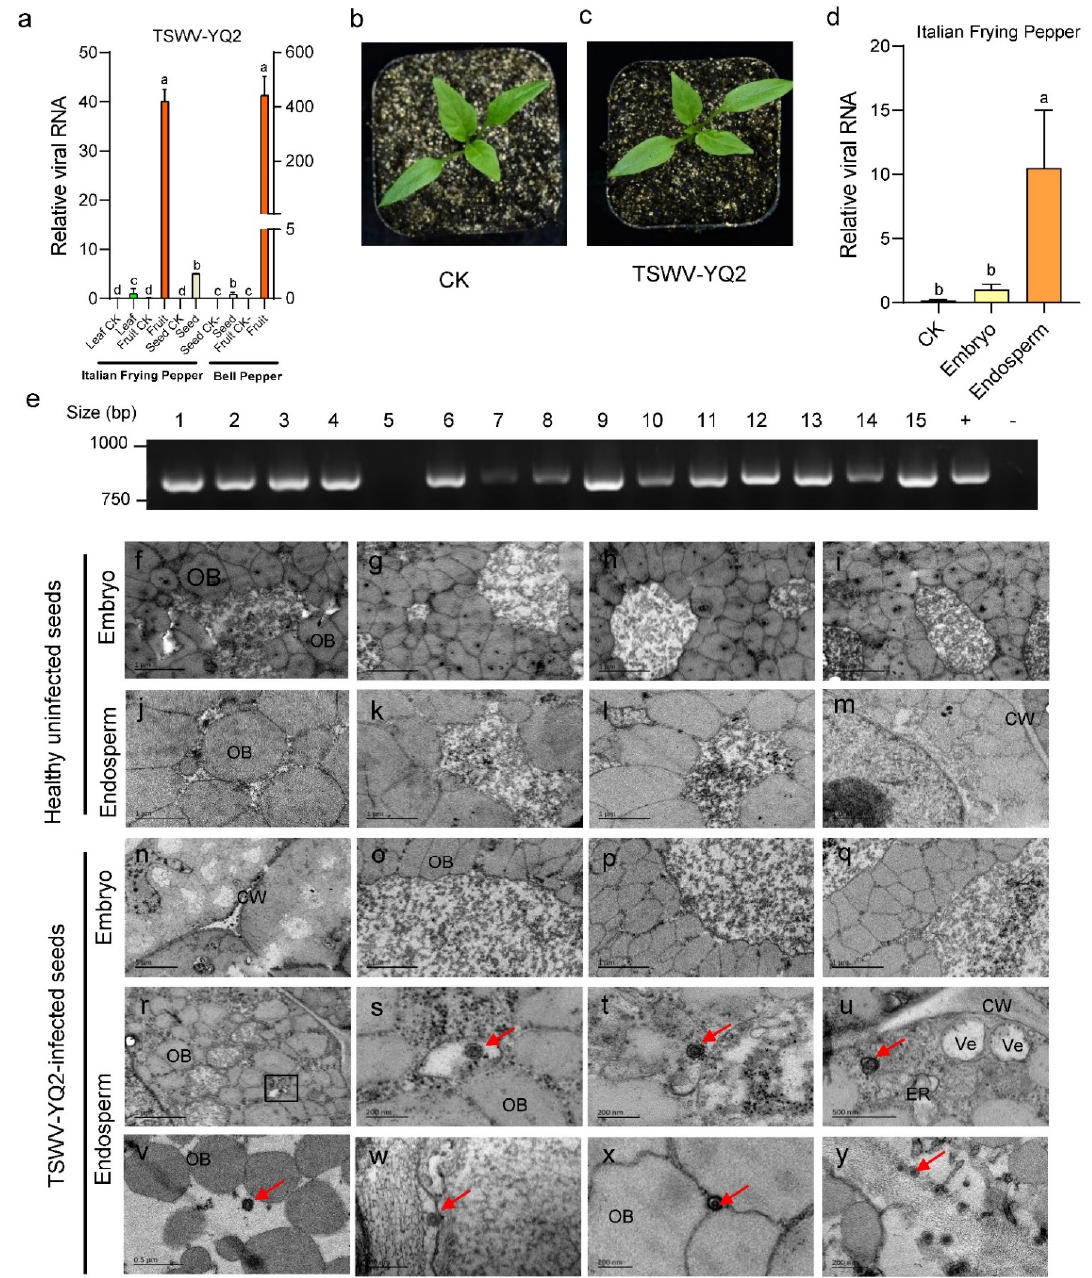
Figure 2. Characterization of seed transmission of TSWV in peppers. ( a ) Relative viral RNA level of the nucleocapsid ( N ) gene in the leaves, fruits, and seeds of TSWV-YQ2-infected Italian frying peppers and in the fruits and seeds of TSWV-YQ2-infected bell peppers. Leaf CK/fruit CK/seed CK, leaf/fruit/seed negative control (healthy uninfected Italian frying pepper leaves/fruits/seeds). Seed CK/fruit CK, seed/fruit negative control (healthy uninfected bell pepper seeds/leaves). Values are means ± SE, n = 4. Means with different letters (a, b, c, d) are significantly different ( p < 0.05, one-way ANOVA along with Duncan’s multiple range test). Each value was normalized to the leaves. ( b , c ) Seedlings germinated from healthy seed (CK) and seed collected from TSWV-YQ2-infected Italian frying peppers (TSWV-YQ2). ( d ) Relative viral RNA level of the N gene in the embryo and endosperm of TSWV-YQ2-infected Italian frying pepper seeds. CK, nega- tive control (healthy uninfected pepper seeds). Values are the means ± SE, n = 4. Means with dif- ferent letters (a, b) are significantly different ( p < 0.05, one-way ANOVA along with Duncan’s multiple range test). Each value was normalized to the embryo. ( e ) RT-PCR detection of the N gene of TSWV in 15 seedlings germinated from TSWV-YQ2-infected Italian frying pepper seeds. +, positive control (TSWV-YN1-infected pepper leaves from the laboratory, preserved); − , negative